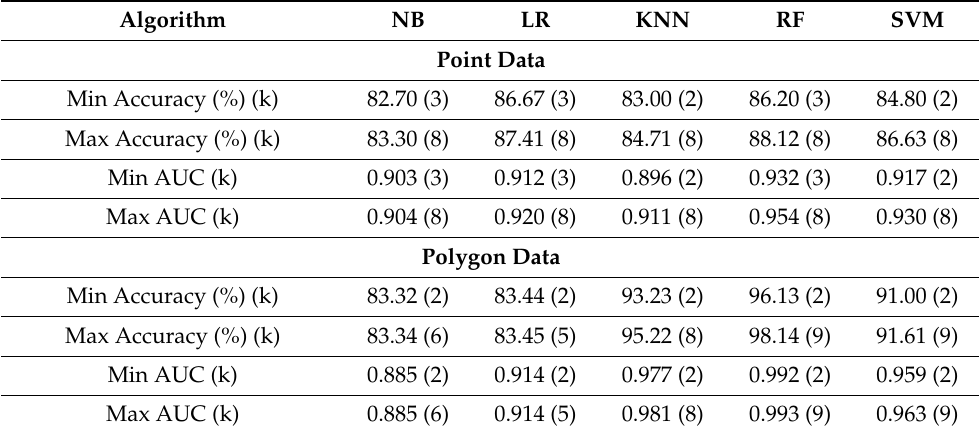
Table 2. Quantitative comparison of different algorithms, sampling strategies and data splitting using accuracy and AUC